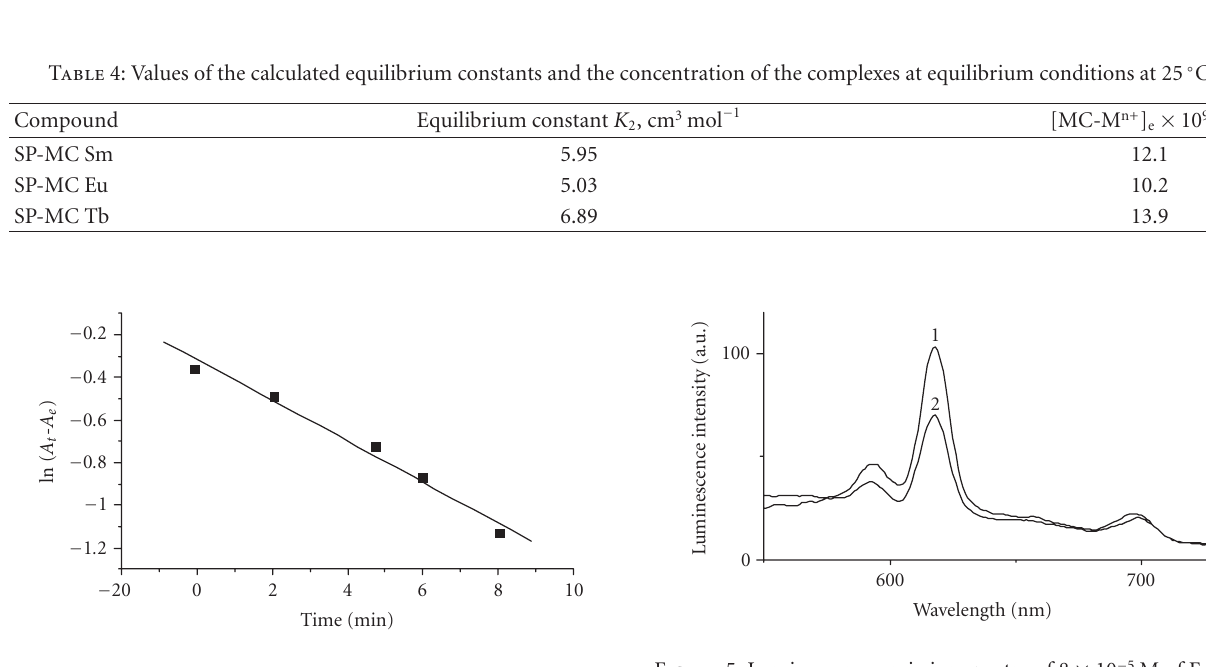
Figure 4: ln scale for 3 × 10 − 5 M of SP in DMSO. Figure 5: Luminescence emission spectra of 8